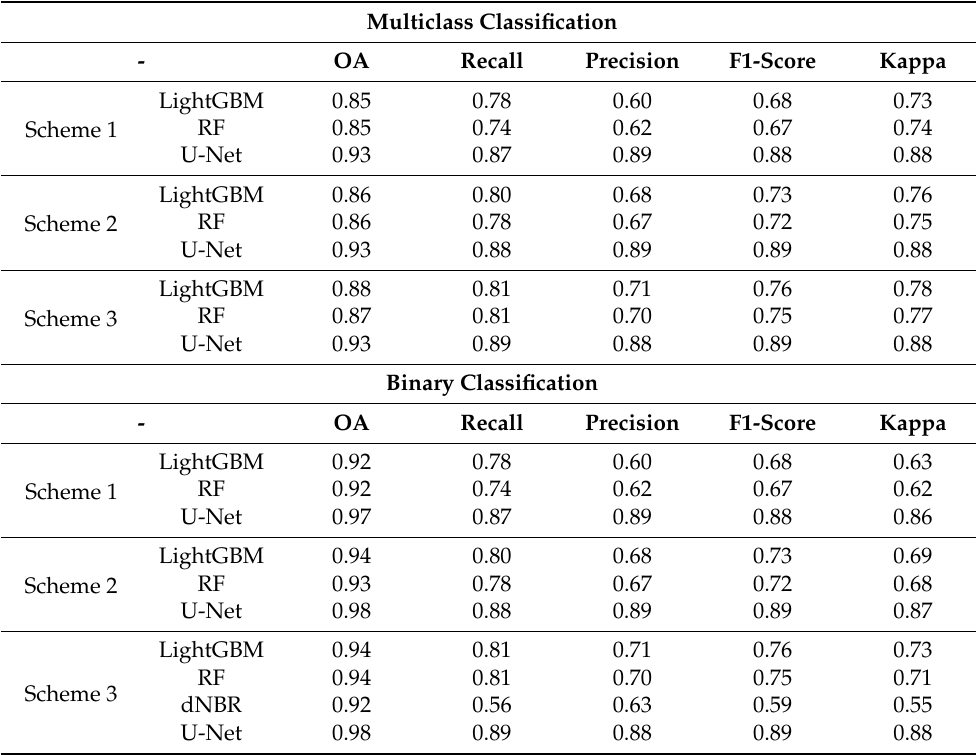
Table 4. Summary of the burned area detection results for Site A.